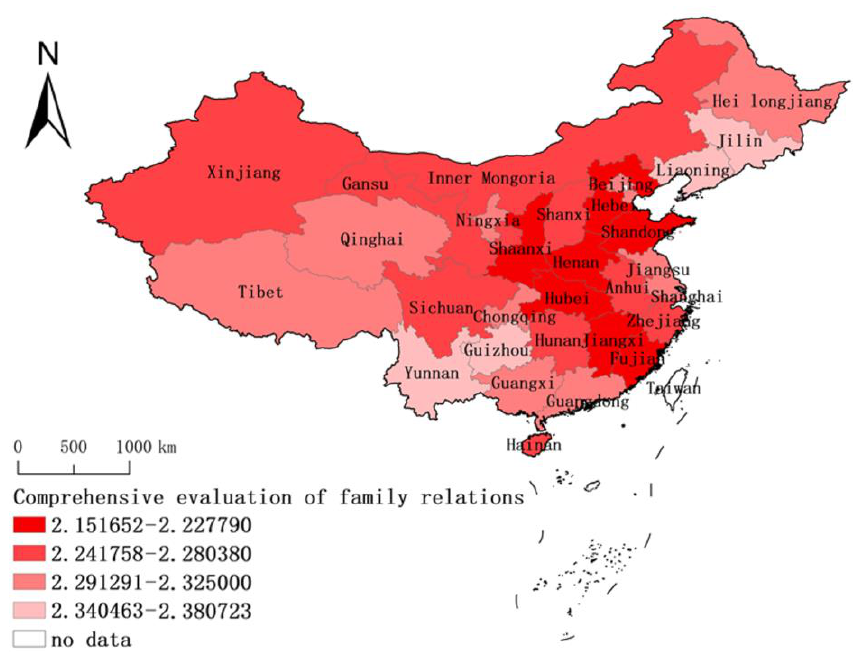
Figure 3. Spatial distribution characteristics of the comprehensive family relationship assessment.